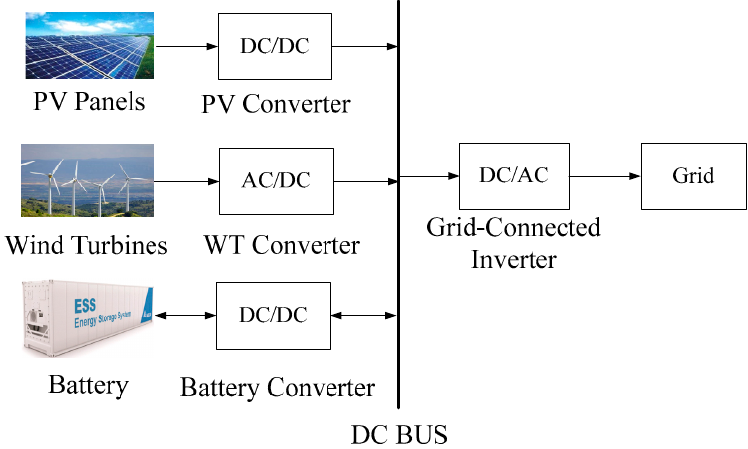
Figure 1. Structure of wind-photovoltaic-battery hybrid generation system (WPB-HGS).